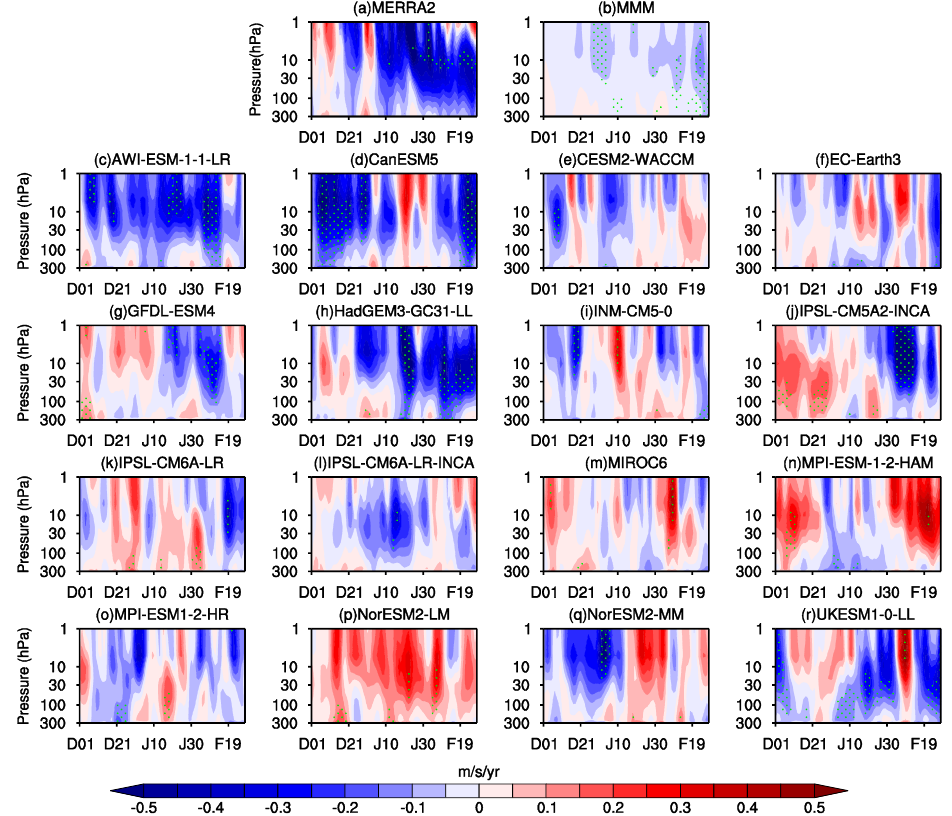
Figure 6. The trend of daily zonal mean zonal wind over the levels between 1 – 300 hPa in the polar cap (60° – 90°N) for the period 1980/81-2013/14 derived from ( a ) MERRA2, ( b ) multi-model mean and ( c – r ) each CMIP6 model simulation. Green dotted regions are for values statistically significant at the 90% confidence level by Student’s t -test.